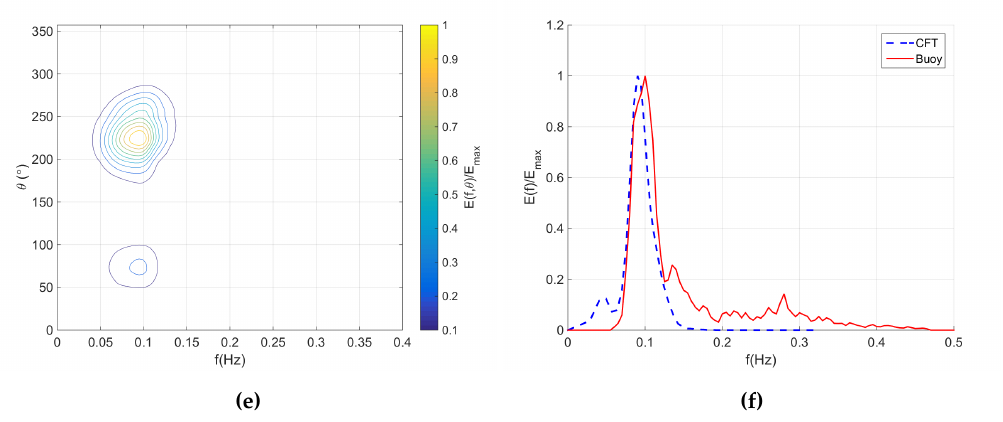
Figure 10. A field data example for wave spectrum estimation using the CFT with the ARPM. Data was recorded on 3 December 2008 at 5:31 AM ( a–f ): ( a , c , e ) The directional wave spectrum estimated in the first, second and third iteration, respectively; ( b , d , f ) The frequency wave spectrum estimated from the radar data in the first, second and third iteration respectively and overlaid on the ground truth frequency wave spectrum.